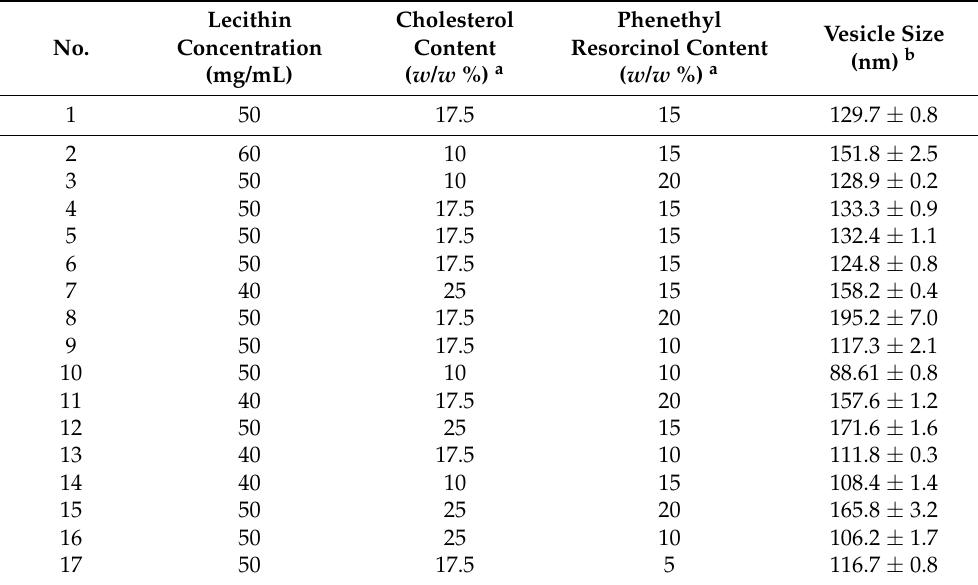
Table 1. Box–Behnken design-selected compositions and response variables of the prepared PR-NLP